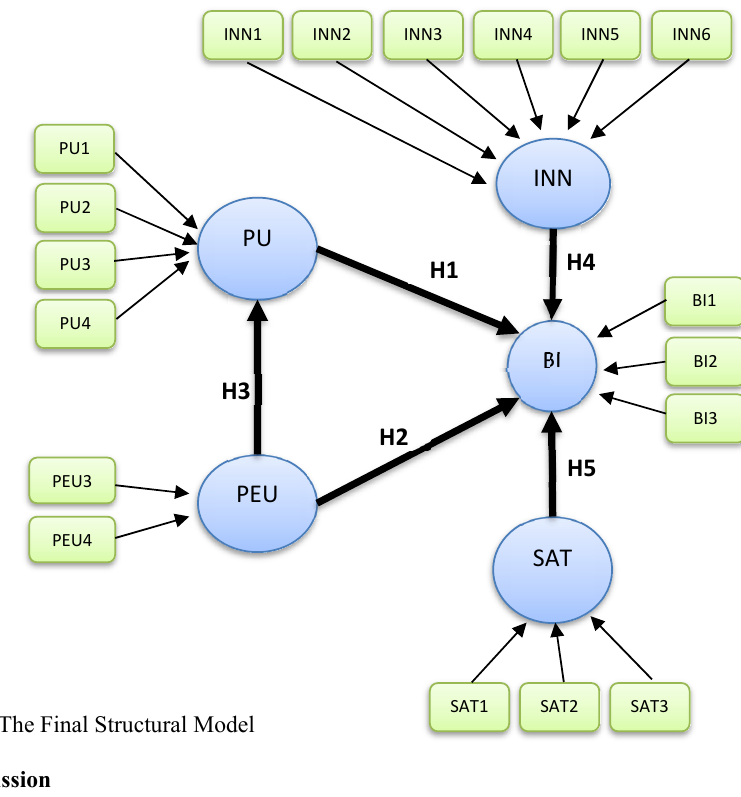
Fig. 3. The Final Structural Model